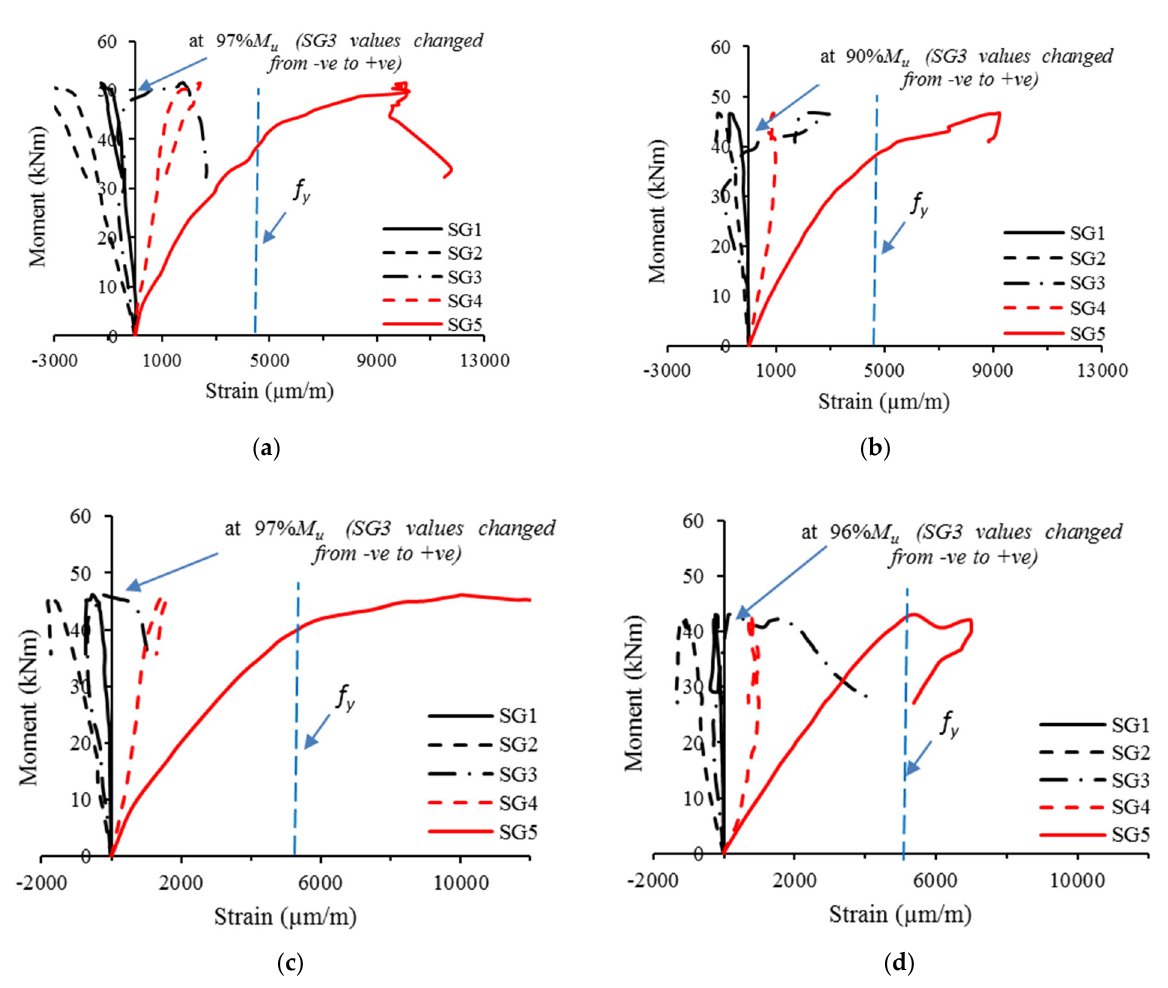
Figure 14. Moment versus strain relationships for specimens. ( a ) CBPDS-DF0; ( b ) CBPDS-DS0; ( c ) CBPDS-DF100; ( d ) CBPDS-DS100. ( c ) CBPDS-DF100; ( d )